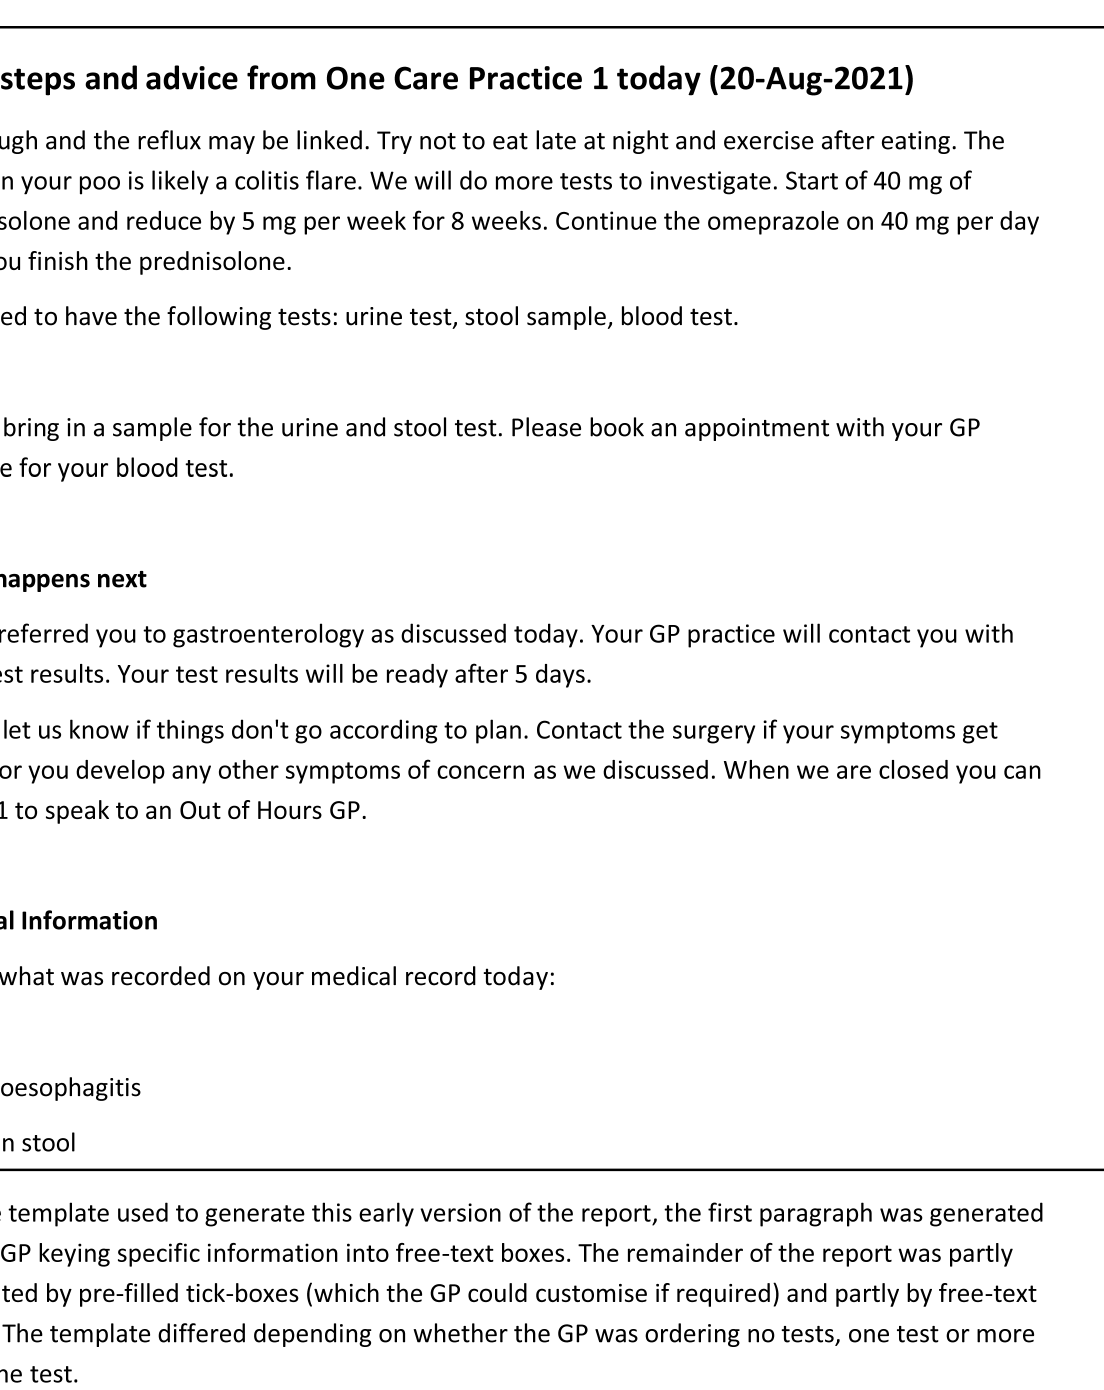
Figure 4. Consultation summary report: Pilot version (start of intervention